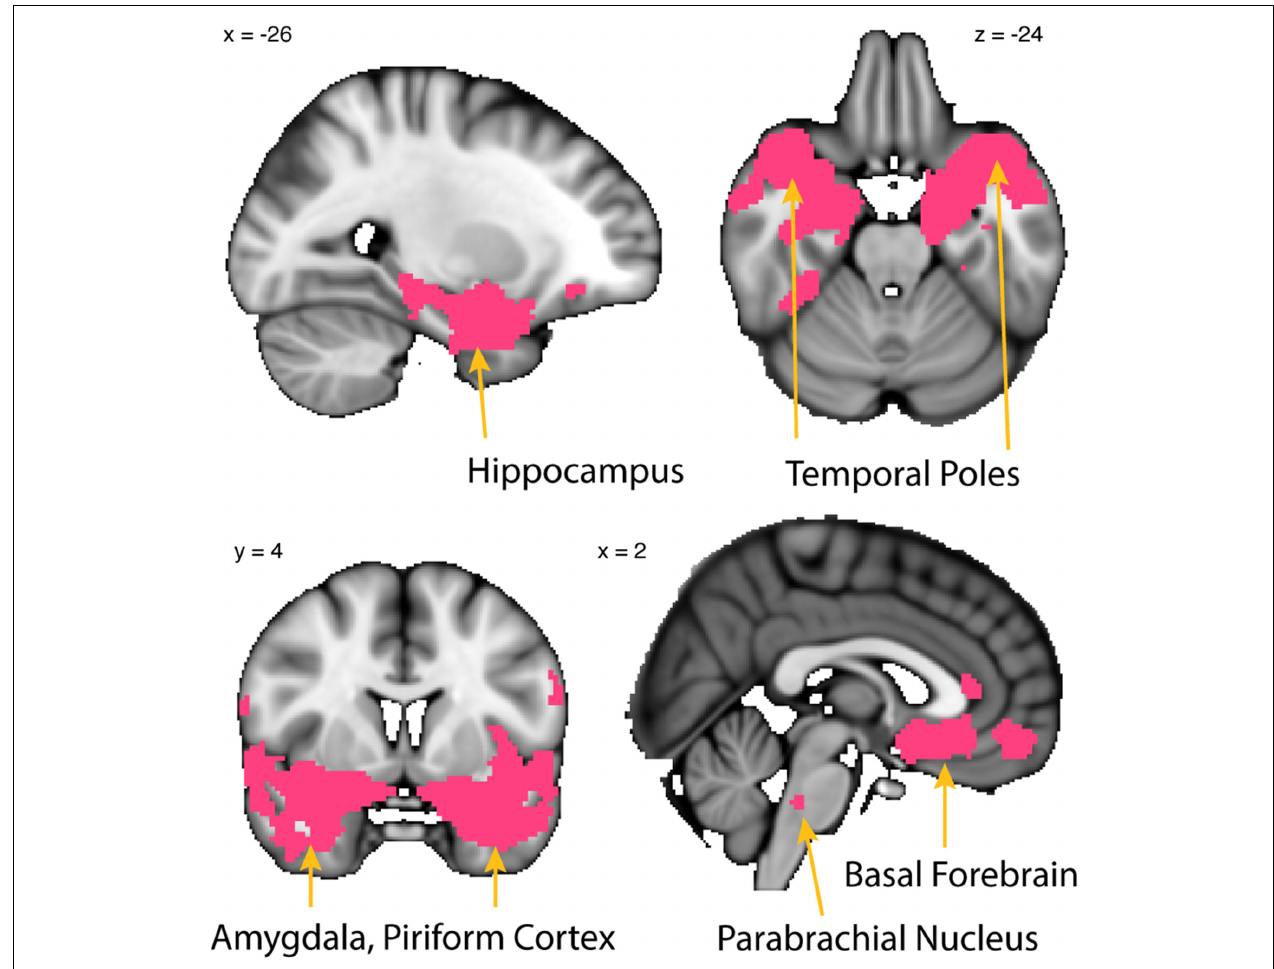
FIGURE 7 | Whole-brain resting connectivity is common to MeA, CoA, and PAC. Regions of interest include the piriform cortex, entorhinal cortex, olfactory tubercle, temporal pole, basal forebrain, and other areas of the amygdala. The connectivity maps were thresholded at threshold-free cluster enhancement corrected P < 0.05. Results are overlaid on FSL’s MNI152_T1_1